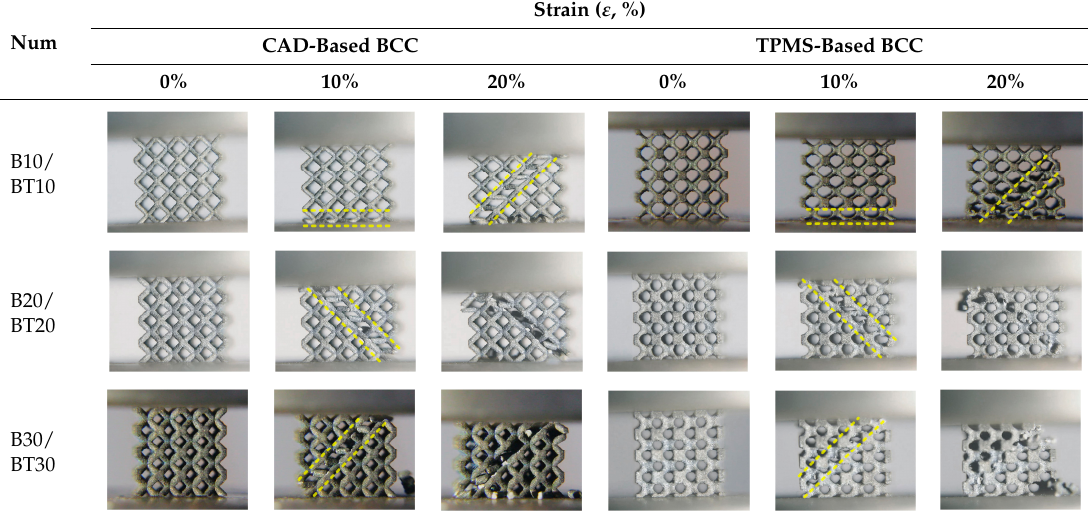
Figure 6. Stress–strain curves of CAD ‐ based and TPMS ‐ based samples in different volume fractions during compression tests. Volume fraction = ( a ) 10%, ( b ) 20%, ( c ) 30%. Table 1. Deformation of CAD ‐ based and TPMS ‐ based samples at different strains during compression tests. Num